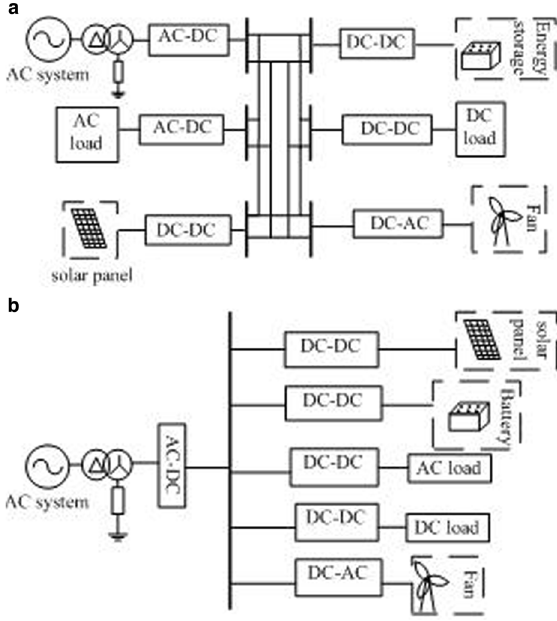
Fig. 2 Parallel type. a Ring connection type. b Tree connection